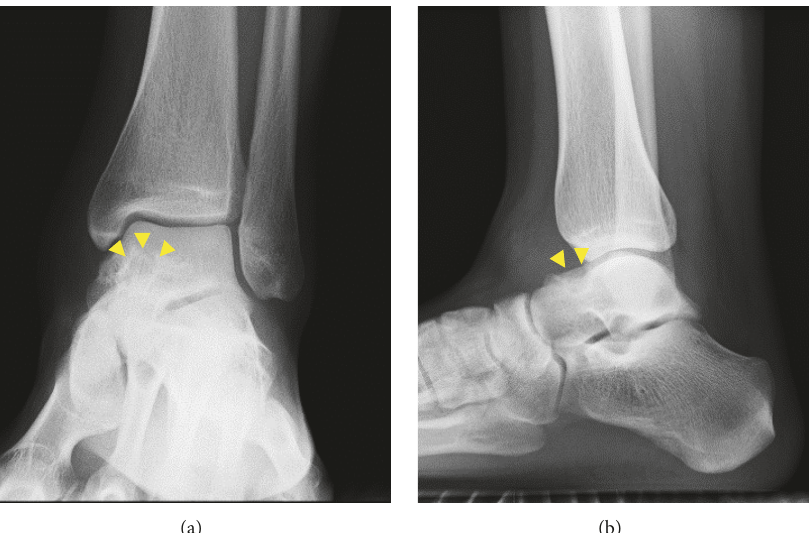
Figure 1: Anteroposterior (a) and lateral (b) plain radiographs of the left ankle showing a radiolucent lesion with marginal sclerosis in the talar neck